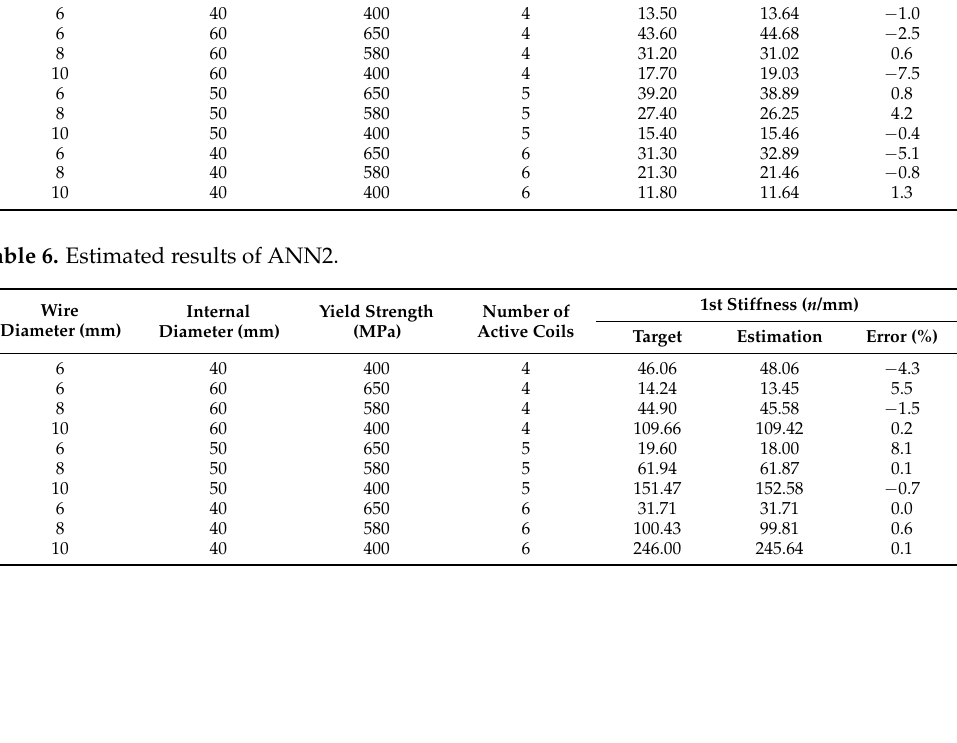
Table 5. Estimated results of ANN1.